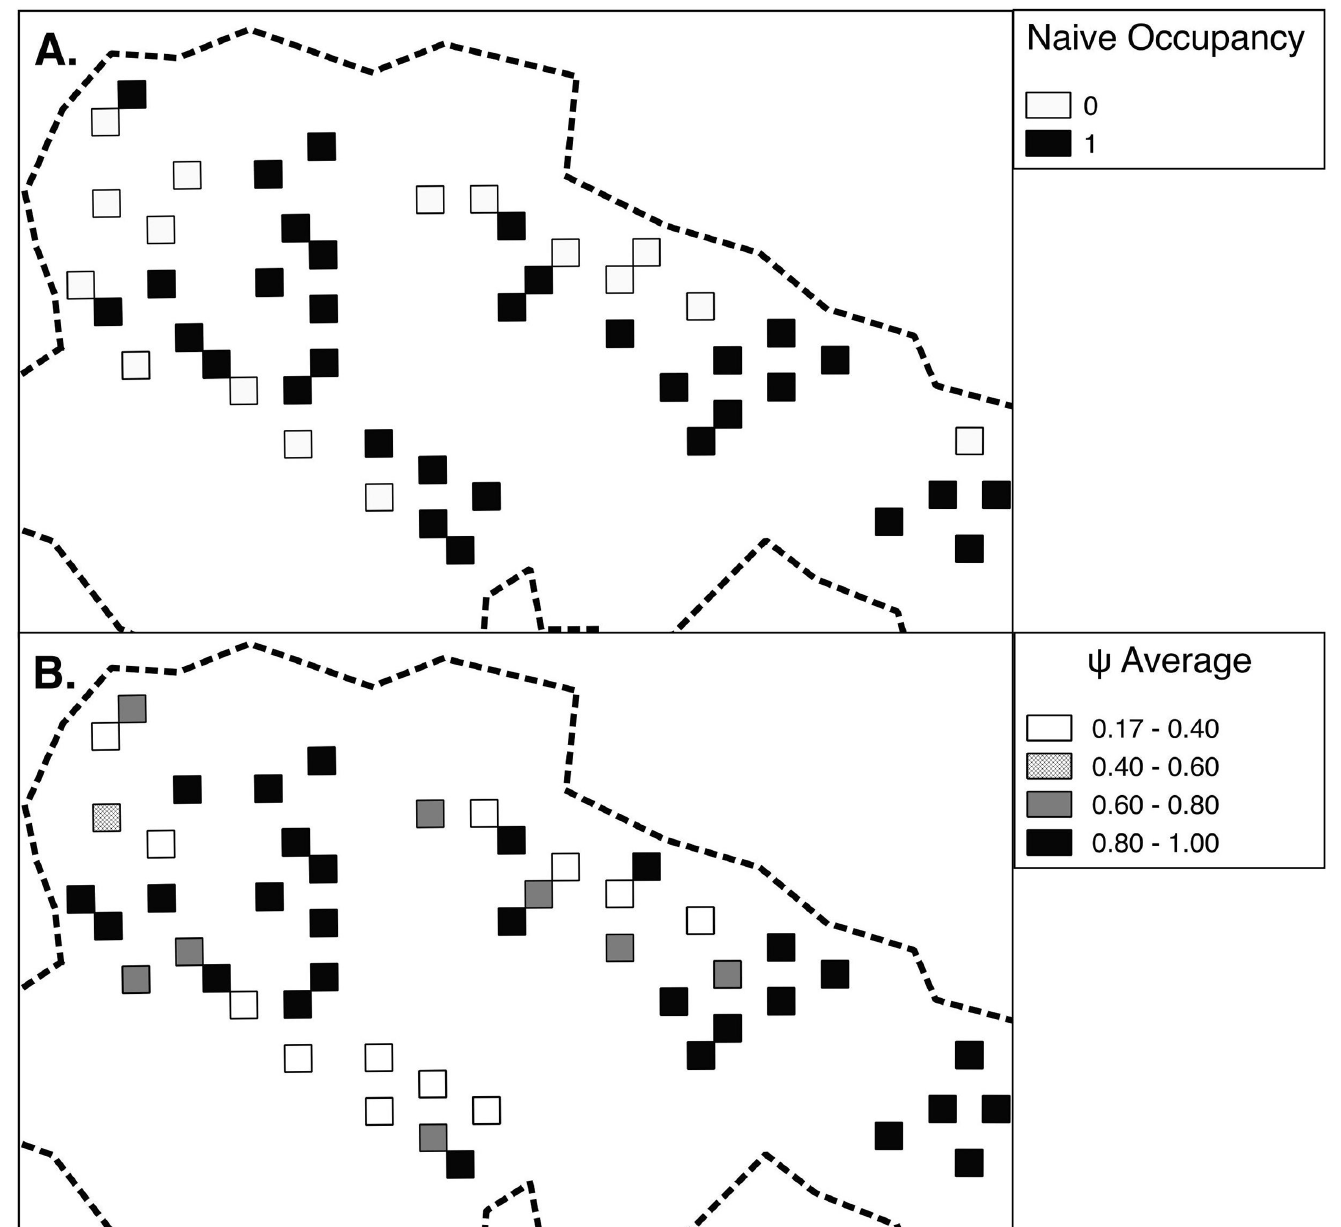
Fig 2. Map of snow leopard site use probability as measured by sign surveys conducted in Qilianshan National Nature Reserve, Gansu Province, China, January to March 2014. A. Na ï ve estimate of site use ( ψ ) from presence vs absence approach and B. Average estimated probabilities of site use ( b c ) per grid